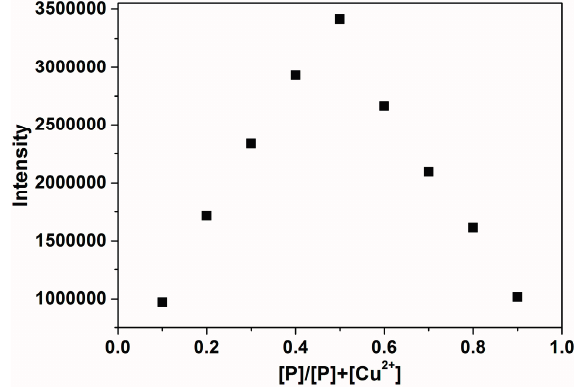
Figure 5. Job’s plot for P- Cu 2+ complex, keeping the total concentration of P and Cu 2+ as 10